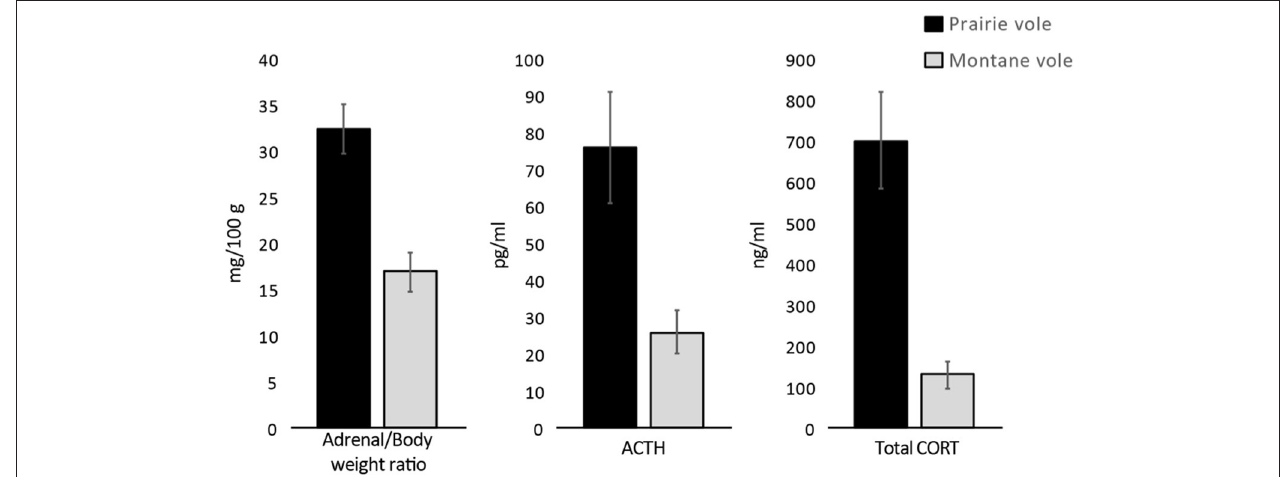
FIGURE 3 | In comparison to non-monogamous montane voles, the socially monogamous prairie vole shows higher unstimulated levels of hormones of the hypothalamic-pituitary-adrenal axis. Adapted from Taymans et al. (1997).